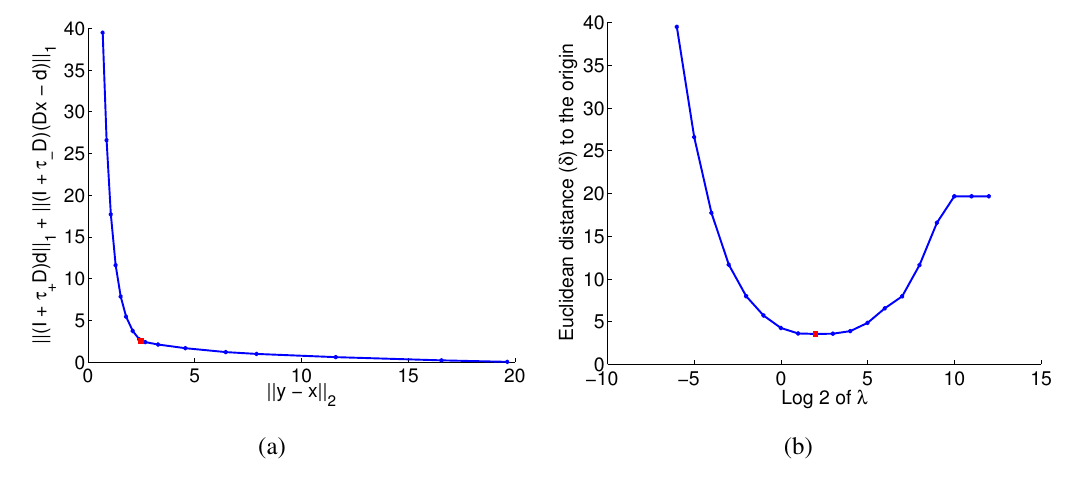
Figure 5. Trade-off curve for an experiment with the Random Stairway strategy, considering the response of the MiCS 2610 sensor for λ = [2 − 6 , 2 12 ] . The selected value, λ = 2 2 , is highlighted with a red